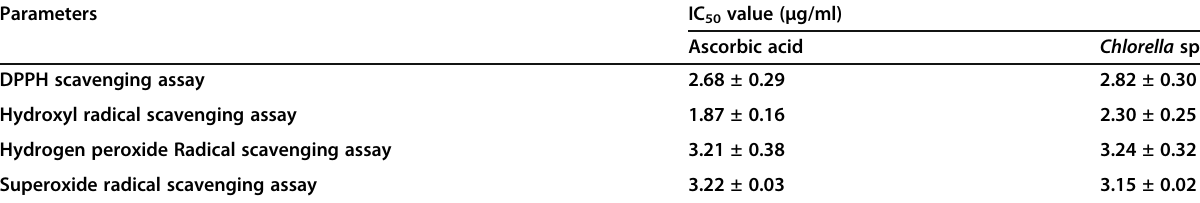
Table 4 IC 50 Values of free radical scavenging activities of the methanol extracts of C. vulgaris